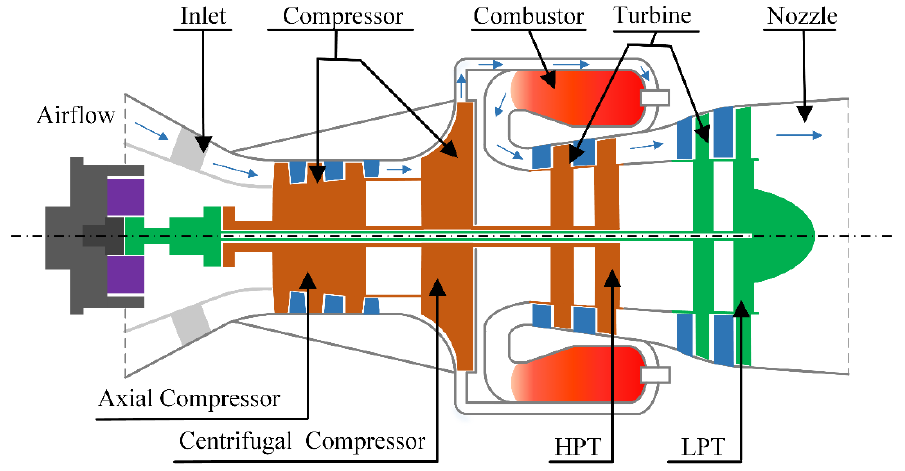
Figure 1. The configuration of the turboshaft engine.